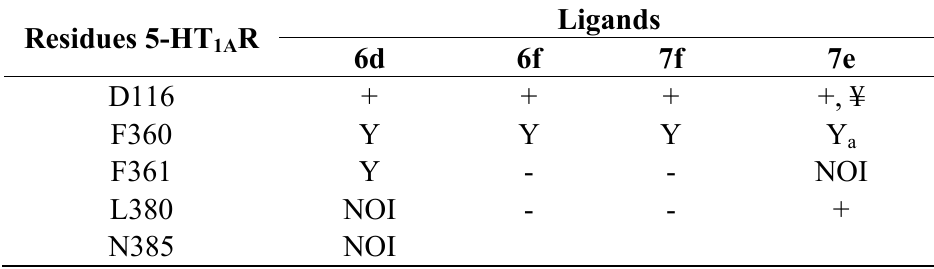
Table 4. Displayed interactions in the binding